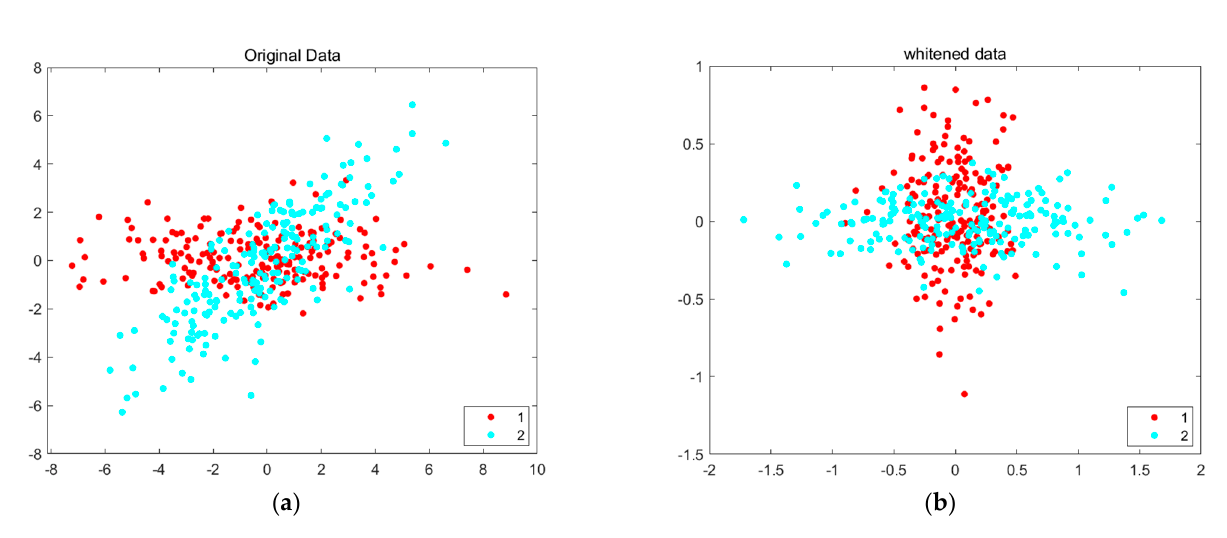
Figure 4. ( a ) Original data and ( b ) whitened